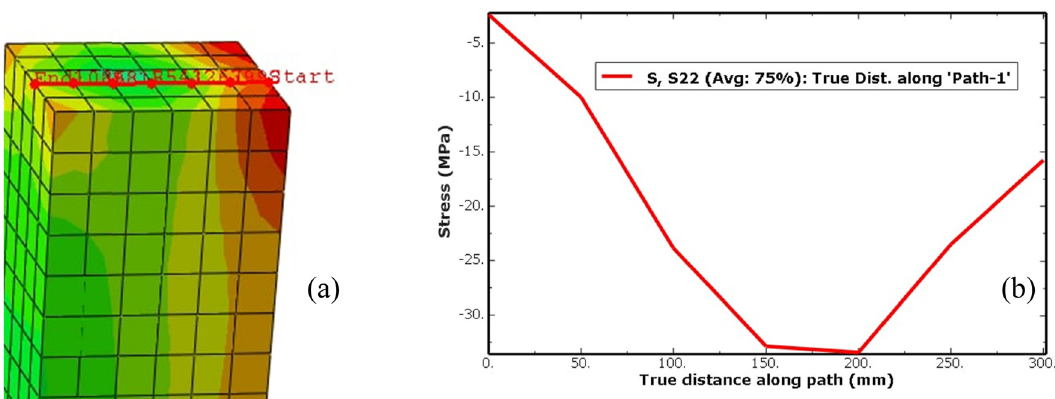
Figure 7: ( a ) Path across the top end of the column and ( b ) S 22 variation along the path.